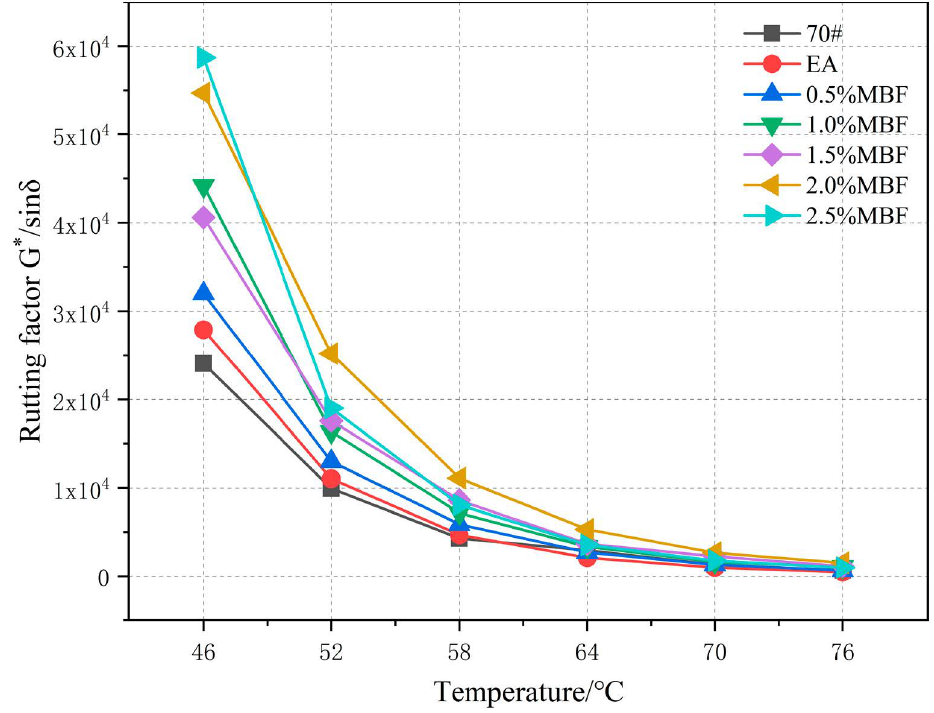
Figure 13. Effect of MBF on G*/sin δ of emulsified asphalt evaporation residue.